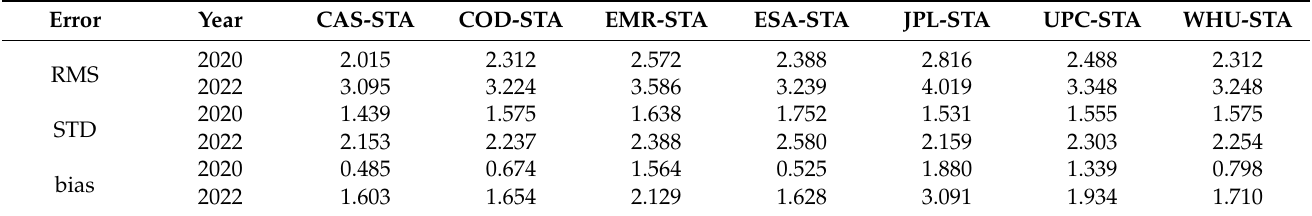
Figure 9. Time series plot of RMS and bias of GIMs with GNSS monitoring stations. Table 5. Accuracy statistics of the difference between GIMs and GNSS monitoring stations, in the units of